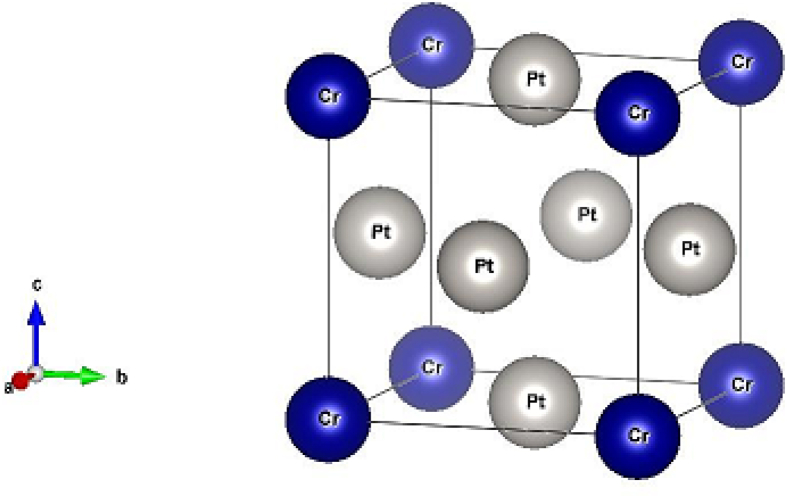
Schematic diagram of AuCu3 (L12) structure of CrPt3 ordered alloys.